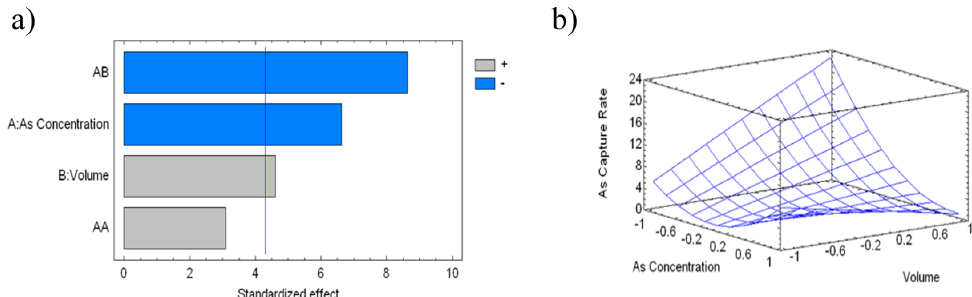
Figure 8. ( a ) Standardized Pareto chart for As capture rate, due to commercial polymer treatment (where: A, As concentration; B, Eluted volume; and AB, AA and BB interactions. Blue line represents critical t -value, 95% confidence); and ( b ) estimated response surface. Table 2. Experiments for affinity by As, performed using Q/VTMSO-SiO 2 . Experiment